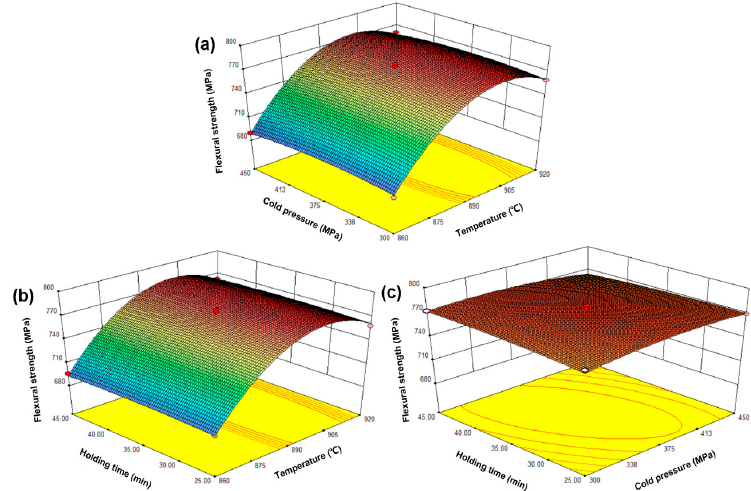
Figure 6. The response surface graph: the effect of sintering temperature, holding time, and cold pressure on the flexural strength of the sintered sample, ( a ) sintering temperature and holding time; ( b ) sintering temperature and cold pressure; ( c ) holding time and cold